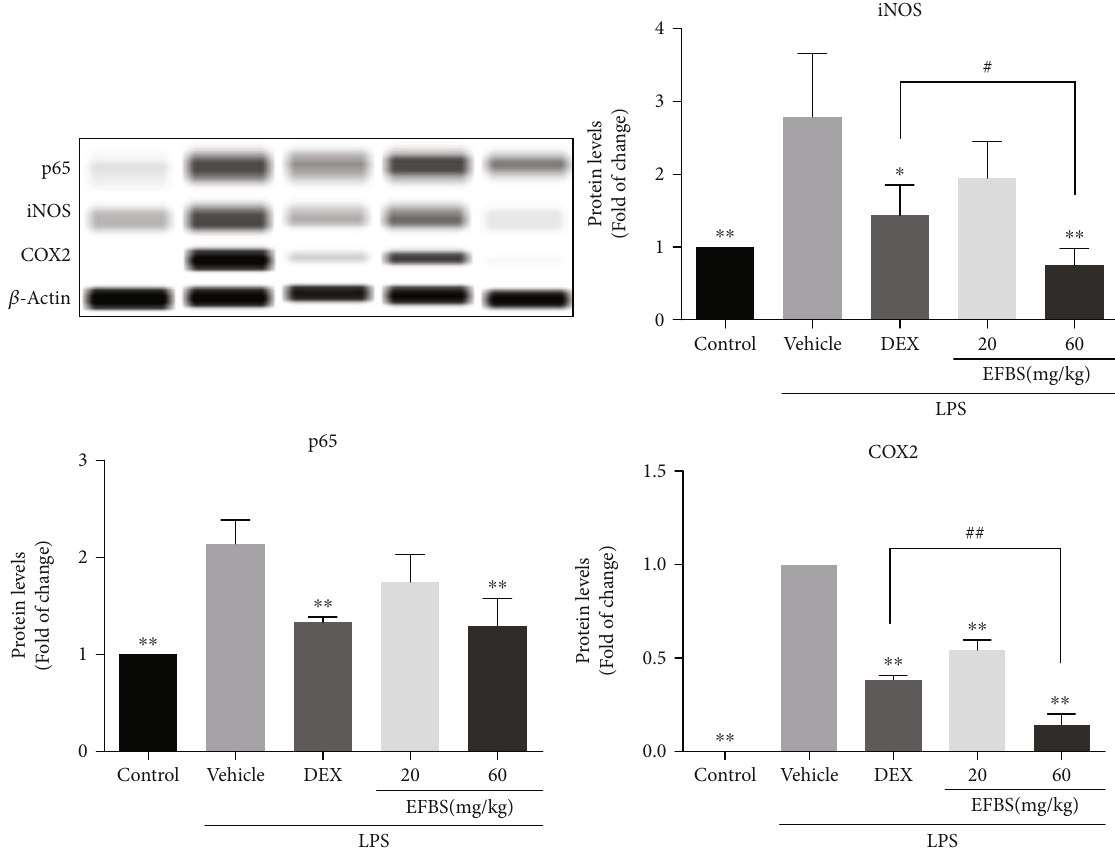
Figure 5: E ff ect of EFBS on LPS-induced COX2, iNOS, and NF- κ B p65 expression in lung tissue. The ICR mice were left untreated or challenged with LPS (5 mg/kg) for 6h following no pretreatment or preadministration of 5 mg/kg DEX, 20mg/kg EFBS, or 60mg/kg EFBS. All mice were sacri fi ced 6 h after LPS administration, and lung tissue was collected for western blot analysis with speci fi c antibodies. Data are expressed as mean ± SD ( n = 3 ). ∗ P < 0 : 05 , ∗∗ P < 0 : 01 compared with the vehicle treatment group. # P < 0 : 05 , ## P < 0 : 01 compared with the DEX treatment